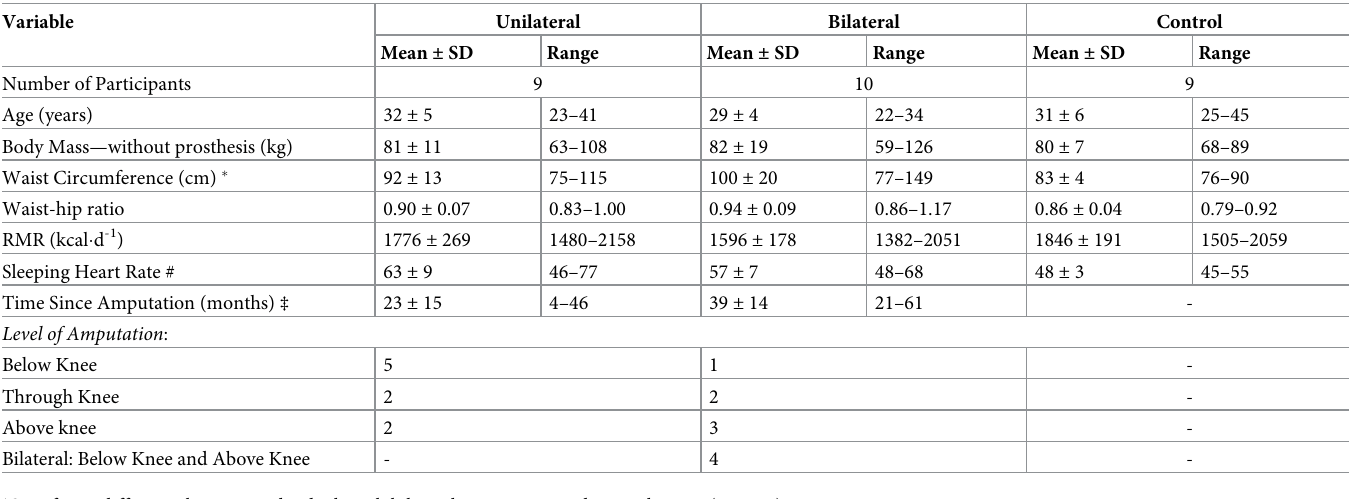
Table 1. Demographic and anthropometric characteristics of the